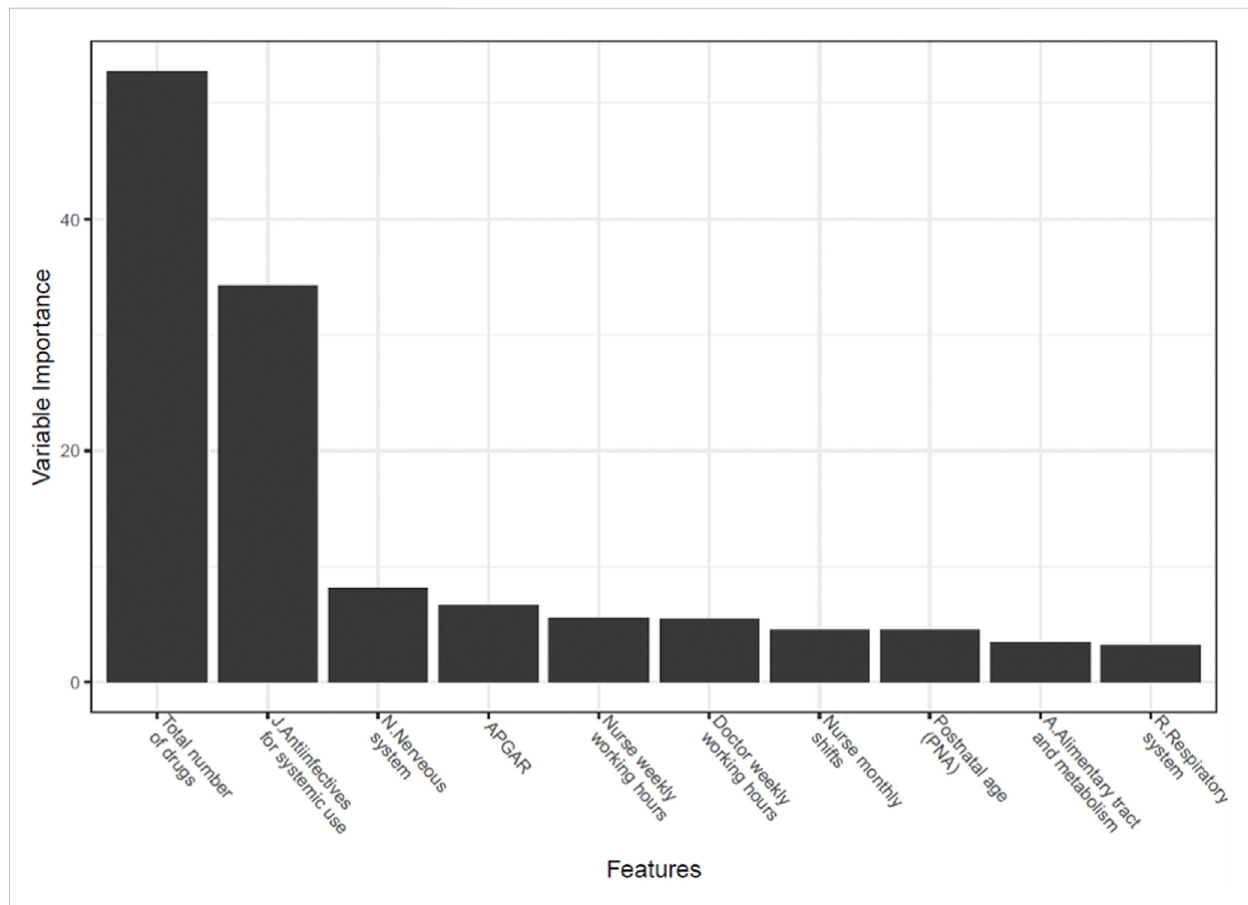
FIGURE 2 Variable importance plot (%) used to predict the presence of medication